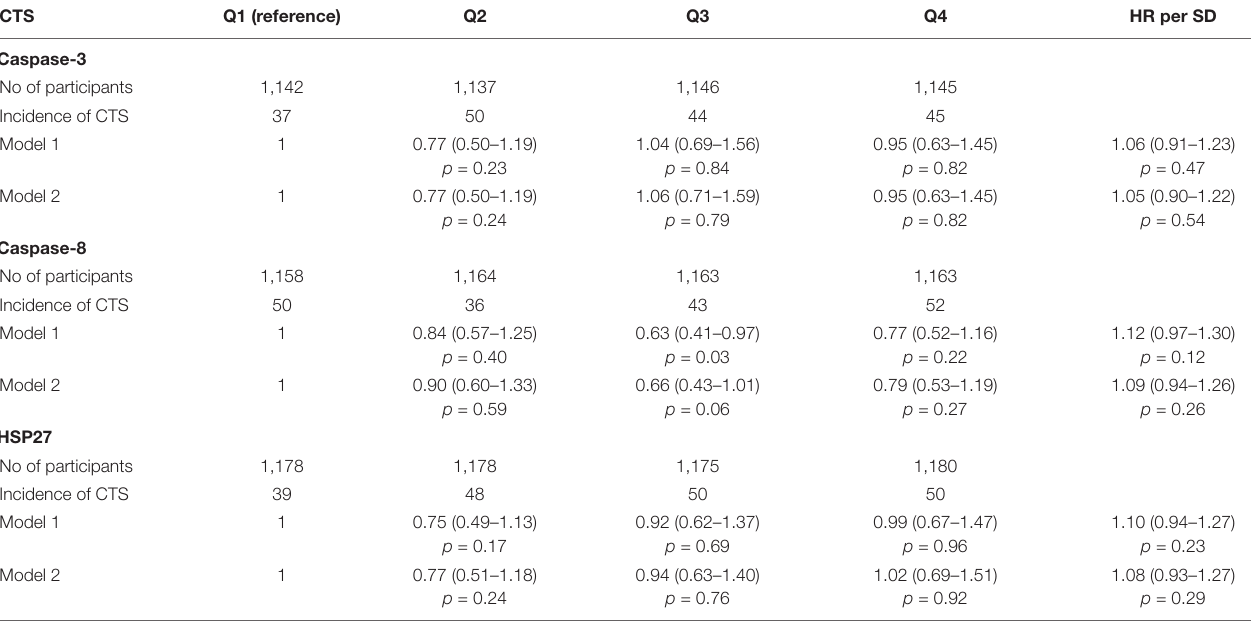
TABLE 3 | Incidence of carpal tunnel syndrome in relation to quartiles of caspase-3, caspase-8 and